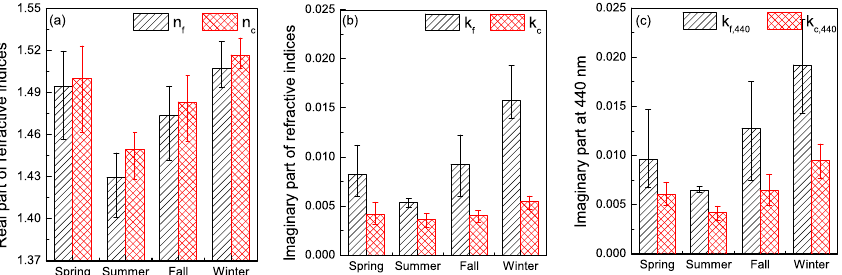
Figure 6. Seasonal mean of the real part (a) , imaginary part (b) and imaginary part at 440nm (c) of sub-mode aerosol refractive indices in Beijing 2014–2015. The “f” and “c” subscripts denote the fine and coarse mode respectively. Error bar shows the maximum and minimum of the monthly mean